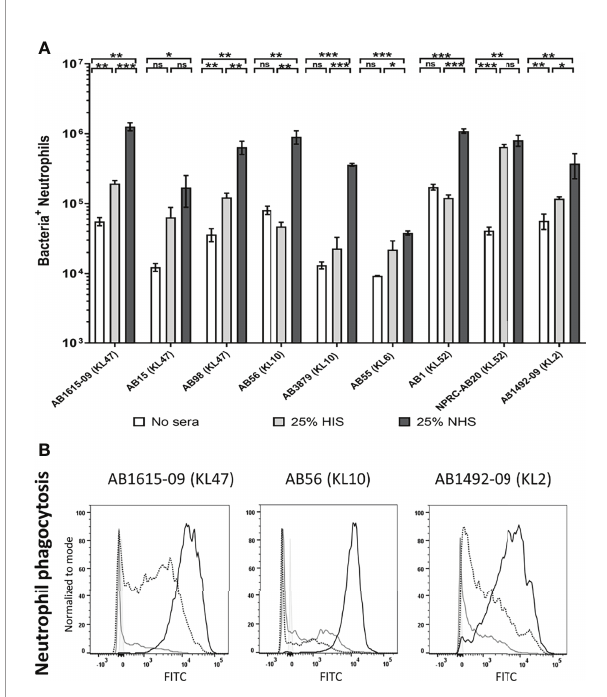
FIGURE 4 | Human complement enhances neutrophil phagocytosis of clinical A. baumanni isolates. Nine FAMSE labelled A. baumannii isolates were opsonized with either 25% heat-inactivated human sera, 25% normal human sera or unopsonised (PBS only) and incubated with healthy human neutrophils at Bacteria: Neutrophil MOI of 200:1. (A) Shows the % of FAMSE +ve Neutrophils * MFI of FAMSE +ve Neutrophils [Mean (± standard deviation)] on the Y axis and the nine isolates with their capsule serotypes are indicated in brackets on the X- axis. Phagocytosis indices in unopsonised bacteria or those incubated with heat- inactivated sera, or normal sera for each isolate is represented in the white, grey, and black bars respectively. (B) Representative histograms showing phagocytosis of FAMSE labelled A. baumannii isolates incubated with either normal sera, heat-inactivated sera or PBS only. Each graph shows a solid grey histogram that represents neutrophils only (no bacteria), open grey histogram represents phagocytosis of unopsonised bacteria, black-dotted line represent phagocytosis of HIS opsonized bacteria and black solid fi lled histogram line represent bacteria opsonized with NS. Bars represent mean values for each condition/strain and the error bars indicate standard deviations (SDs) (n=3). T- test was used for statistical analysis *: p-value < 0.05, **: p-value < 0.01, ***: p- value < 0.001, ns: p-value > 0.05. Representative data from four independent experiments is